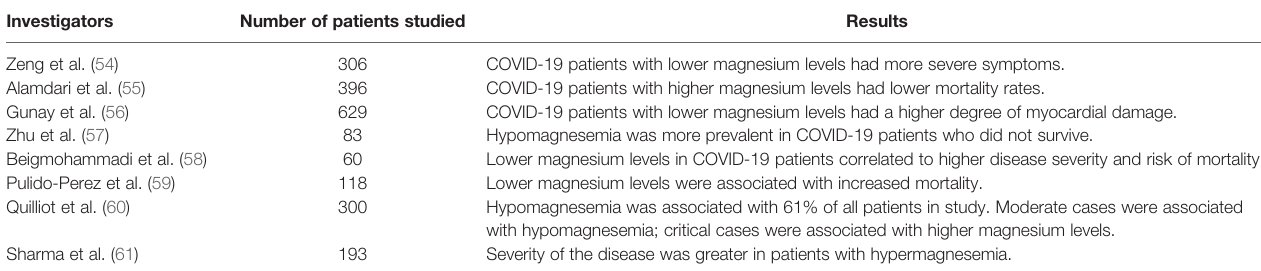
TABLE 1 | Published studies with magnesium status in patients with